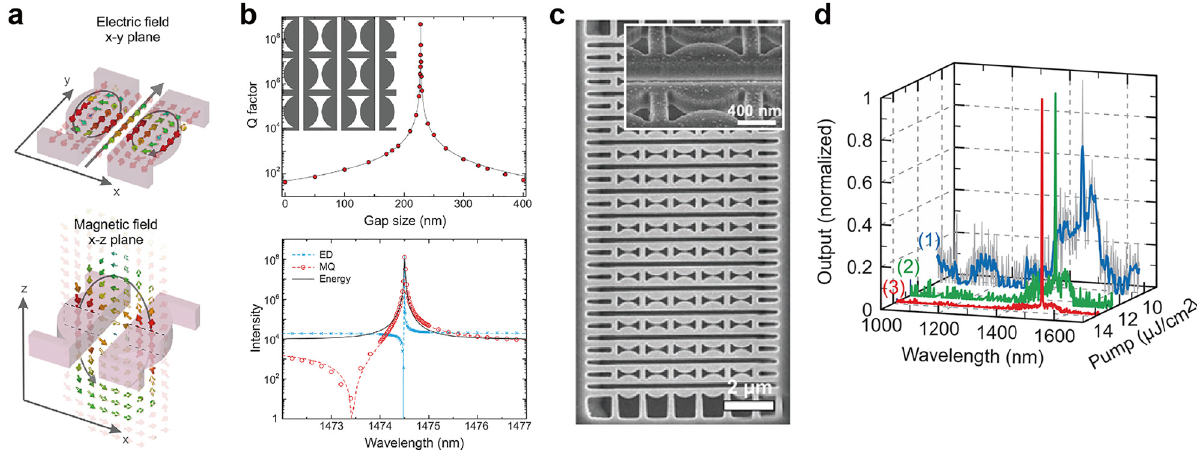
Figure 3: Anapole-based nanolaser. (a) Numerically calculated electric (top) and magnetic (bottom) field cross-sections in the vicinity of the anapole resonance for the split-gap sizeof230nm.Blackarrowsareguidesforaneye.(b)Top,simulated Q factoroftheanapole-typemodeasafunctionofthesplit-gapsize.The inset shows a schematic of top view of the metasurface. Bottom, multipole decomposition at the anapole regime and energy stored by the system. Spectra of the electric dipole moment, the magnetic quadrupole moment, and the stored energy are indicated by blue crosses, red opencircles,andblacksolidcurve,respectively.Thegapsizeis230nm.(c)SEMimageofthefabricatedmetasurface.Across-sectionalviewis shown in the inset. (d) Evolution of the normalized output power as a function of the pump fl uence and wavelength (adopted from Ref.